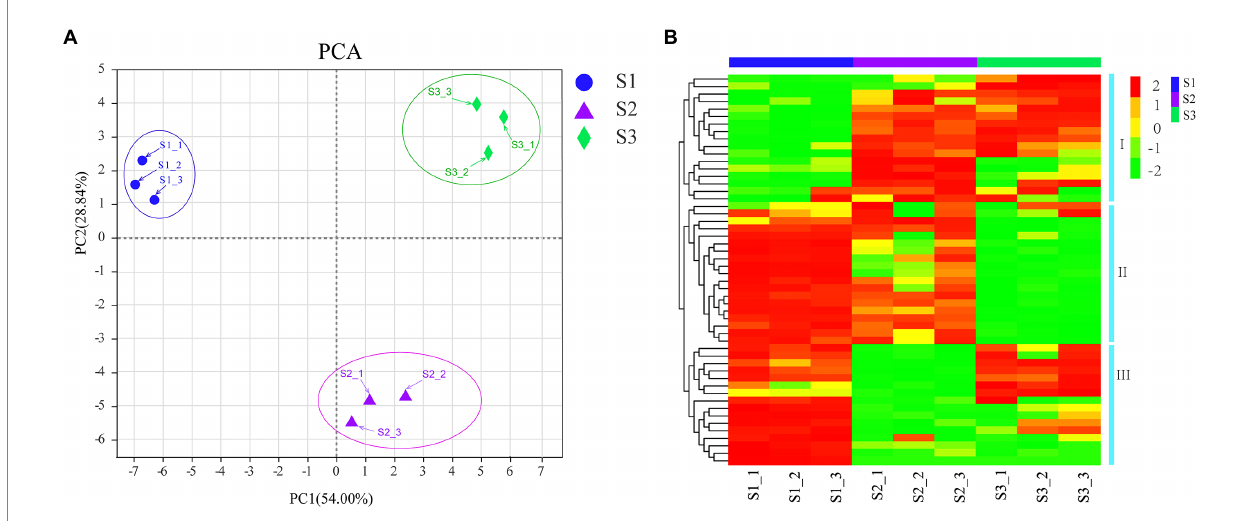
FIGURE 2 PCA and clustering heat map of flavonoid compounds. (A) PCA score plots; (B) Clustering heatmap were drawn with the relative contents of flavonoid compounds. Red and green colors represent the higher or lower content of flavonoid metabolites,